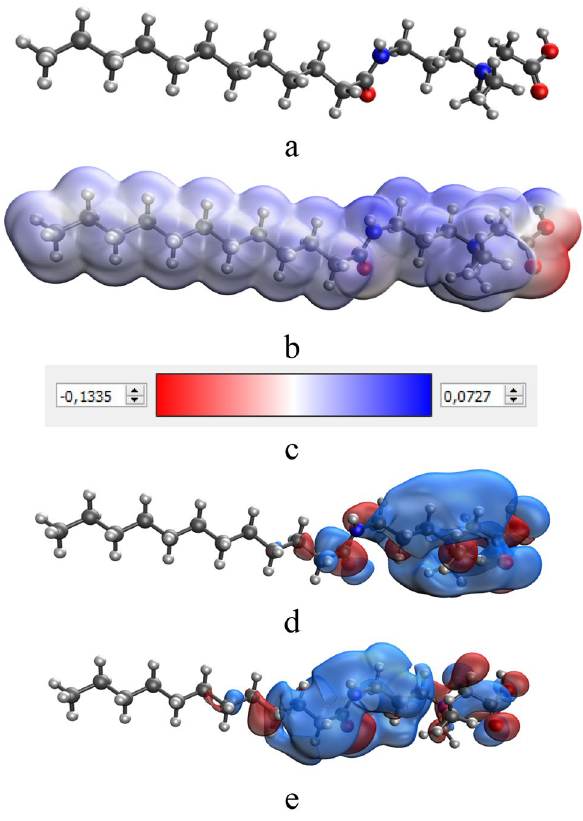
Figure 3. Quantum chemical modeling of CAPB molecule: ( a ) model of the molecule, ( b ) electron density distribution, ( c ) electron density distribution gradient, ( d ) the highest occupied molecular orbital (HOMO), ( e ) the lowest occupied molecular orbital